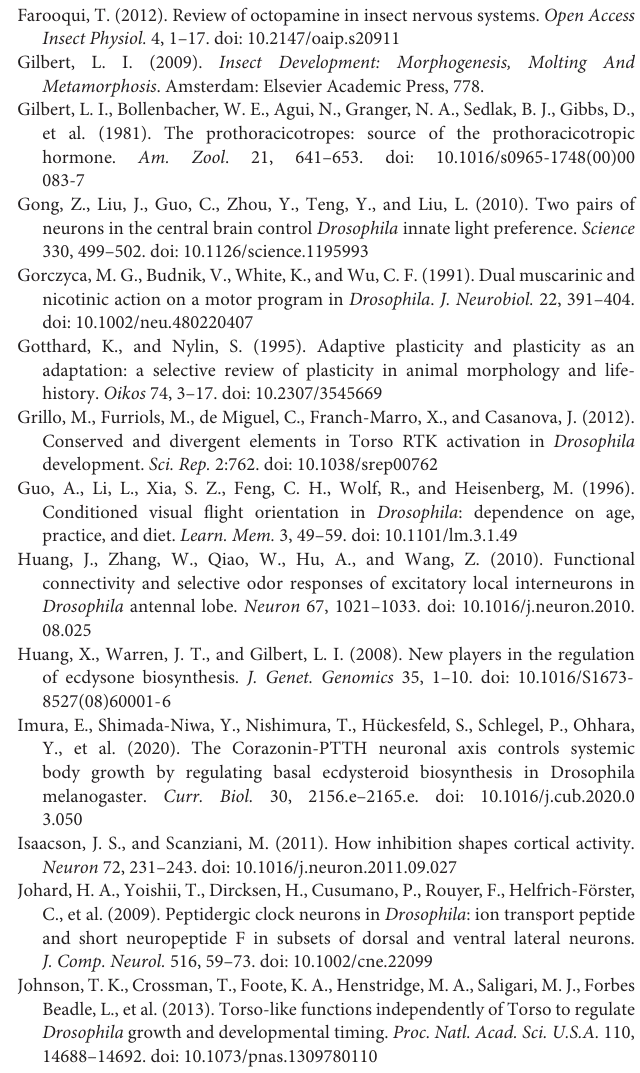
Supplementary Figure 1 | The mRNA expression levels of different AChRs in Drosophila brains were suppressed using the RNAi technique. The RT-PCR results shown are expressed as the ratio of AChR to actin. The mRNA expression of nAChR α 1 (A) , nAChR α 3 (B) , mAChR-B (C) , and mAChR-C (D) was significantly reduced in RNAi knockdown lines compared with compared with their corresponding control groups ( ∗ p < 0.05, ∗∗ p < 0.01, and ∗∗∗ p < 0.001, t